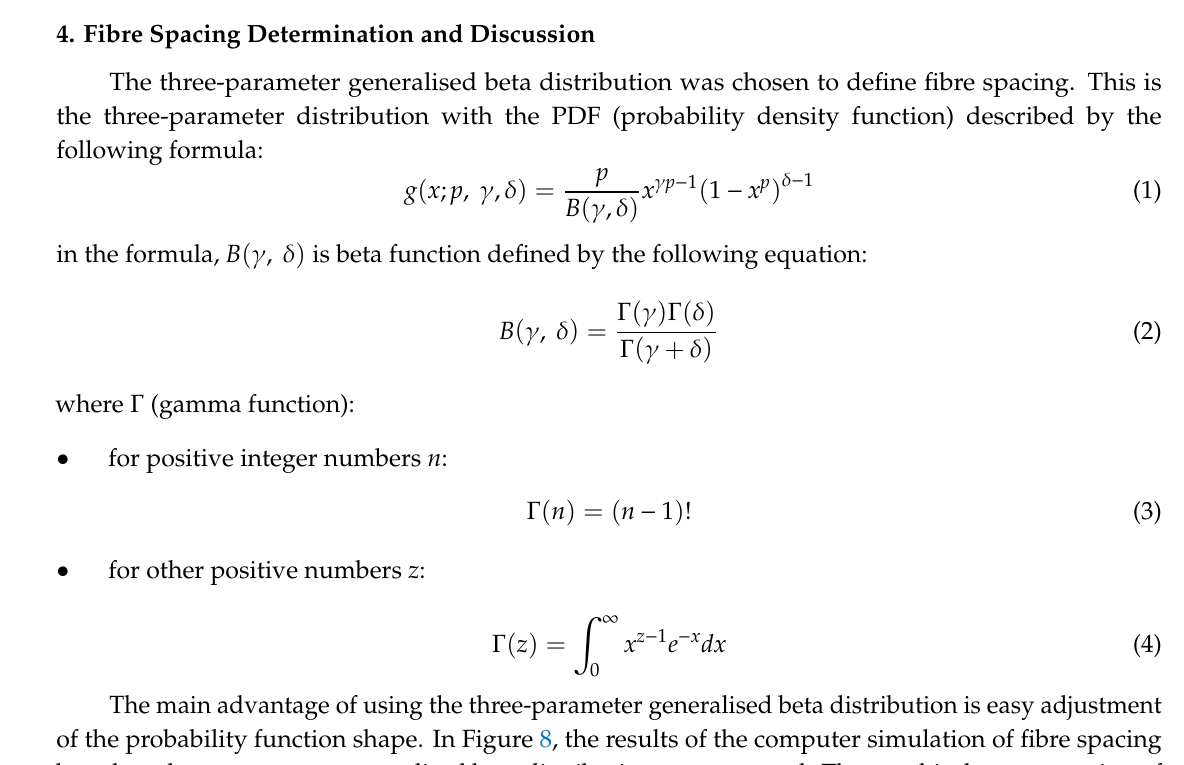
Figure 7. Three-dimensional visualisation of data obtained by the radar-based technique.